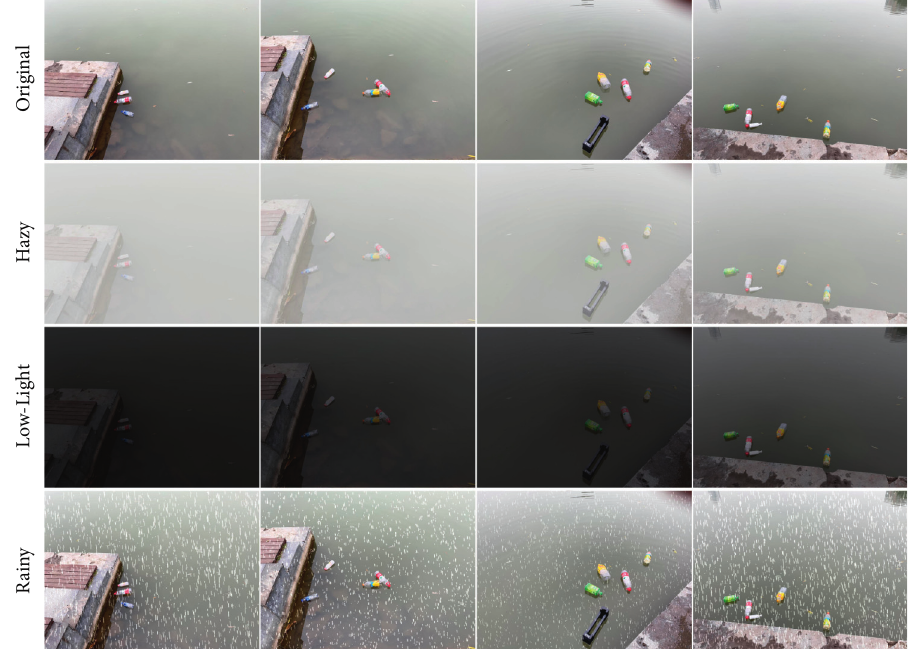
Figure 5: The synthetically degraded images selected to evaluate the detection performance. From top to bottom: original images and degraded versions generated under hazy, low-light, and rainy imaging conditions,